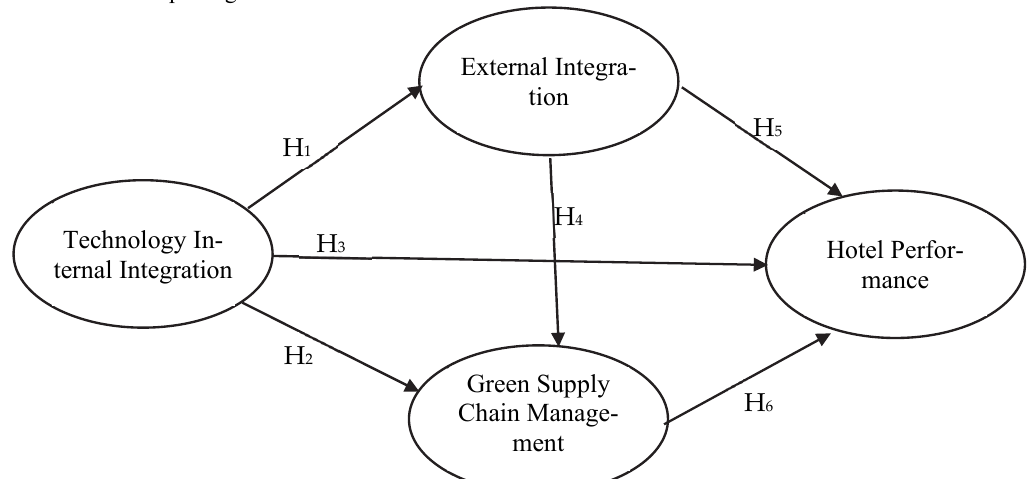
Fig. 1. Research Model Green Supply Chain Management in Hotel